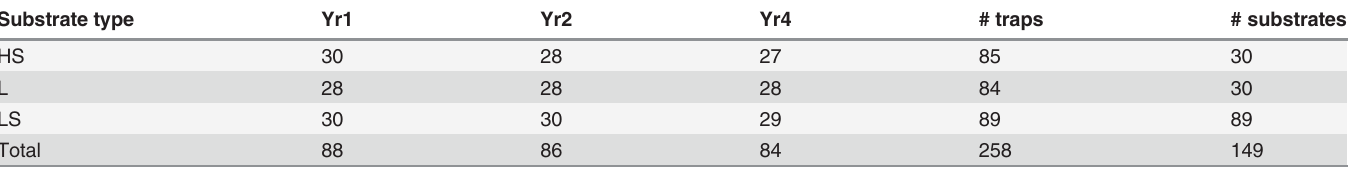
Table 1. The number of traps and